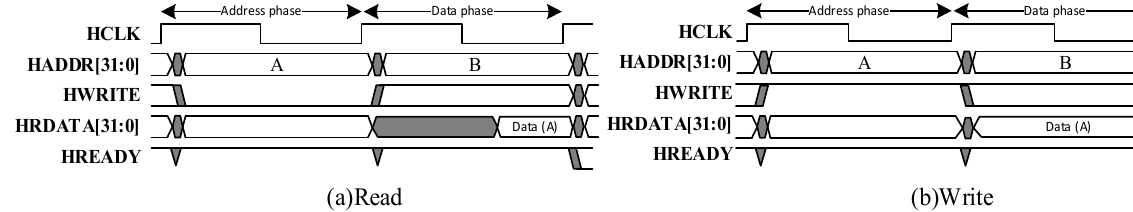
Figure 4. Overall architecture of coprocessor IP.